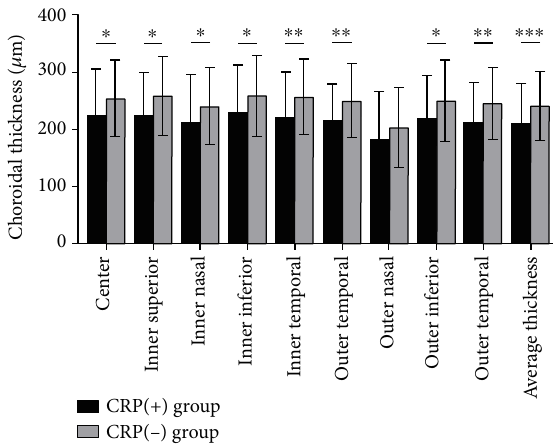
Figure 2: The choroidal thickness of nine sectors of the ETDRS grid. The choroidal thickness in the CRP ( − ) group was signi fi cantly thinner than that in the CRP ( − ) group except for the outer nasal sector. ∗ p < 0 : 05 , ∗∗ p < 0 : 01 , and ∗∗∗ p < 0 : 001